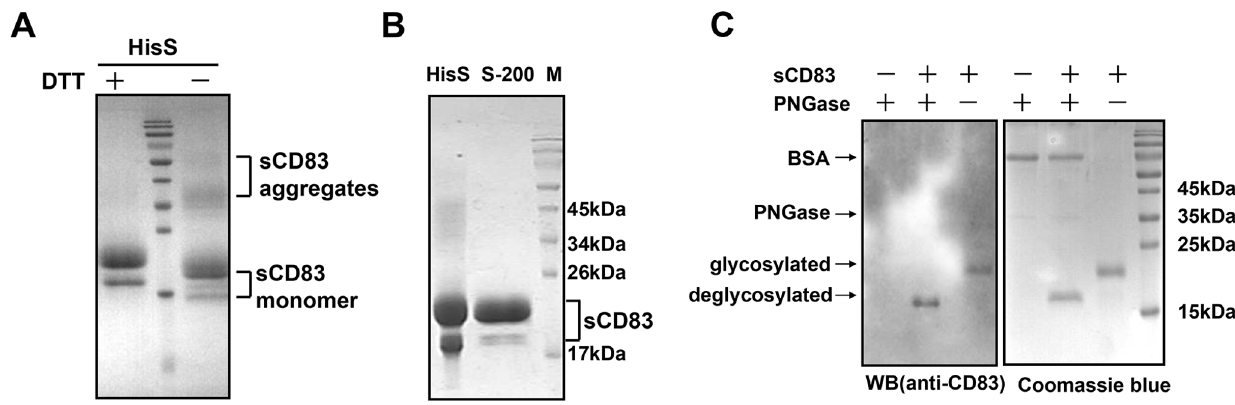
Figure 4. The purification and characterization of sCD83. (A) The isolation of sCD83 by HisS from the fermentation supernatant. HisS: His- Select chromatography. (B) The further purification of sCD83 by S-200. S-200: size-exclusion chromatography S-200 HR, M: pre-stained protein molecular marker. (C) Approximately 20 m g of sCD83 was incubated with 2.0 IU of PNGase F according to the manufacturer’s instructions. The reaction mixture was analyzed in 15% SDS-PAGE and stained with Coomassie blue. Western blotting was performed using anti-CD83 polyclonal